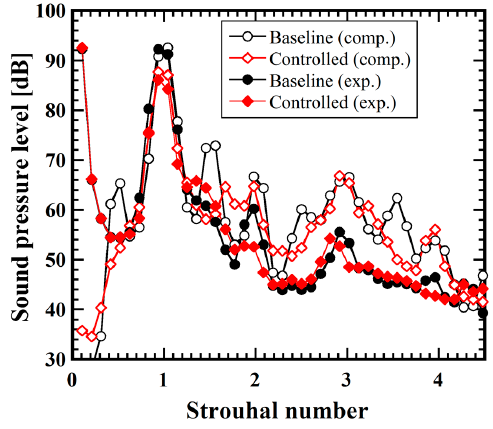
Figure 13. Predicted and measured sound-pressure spectra, both with and without control.